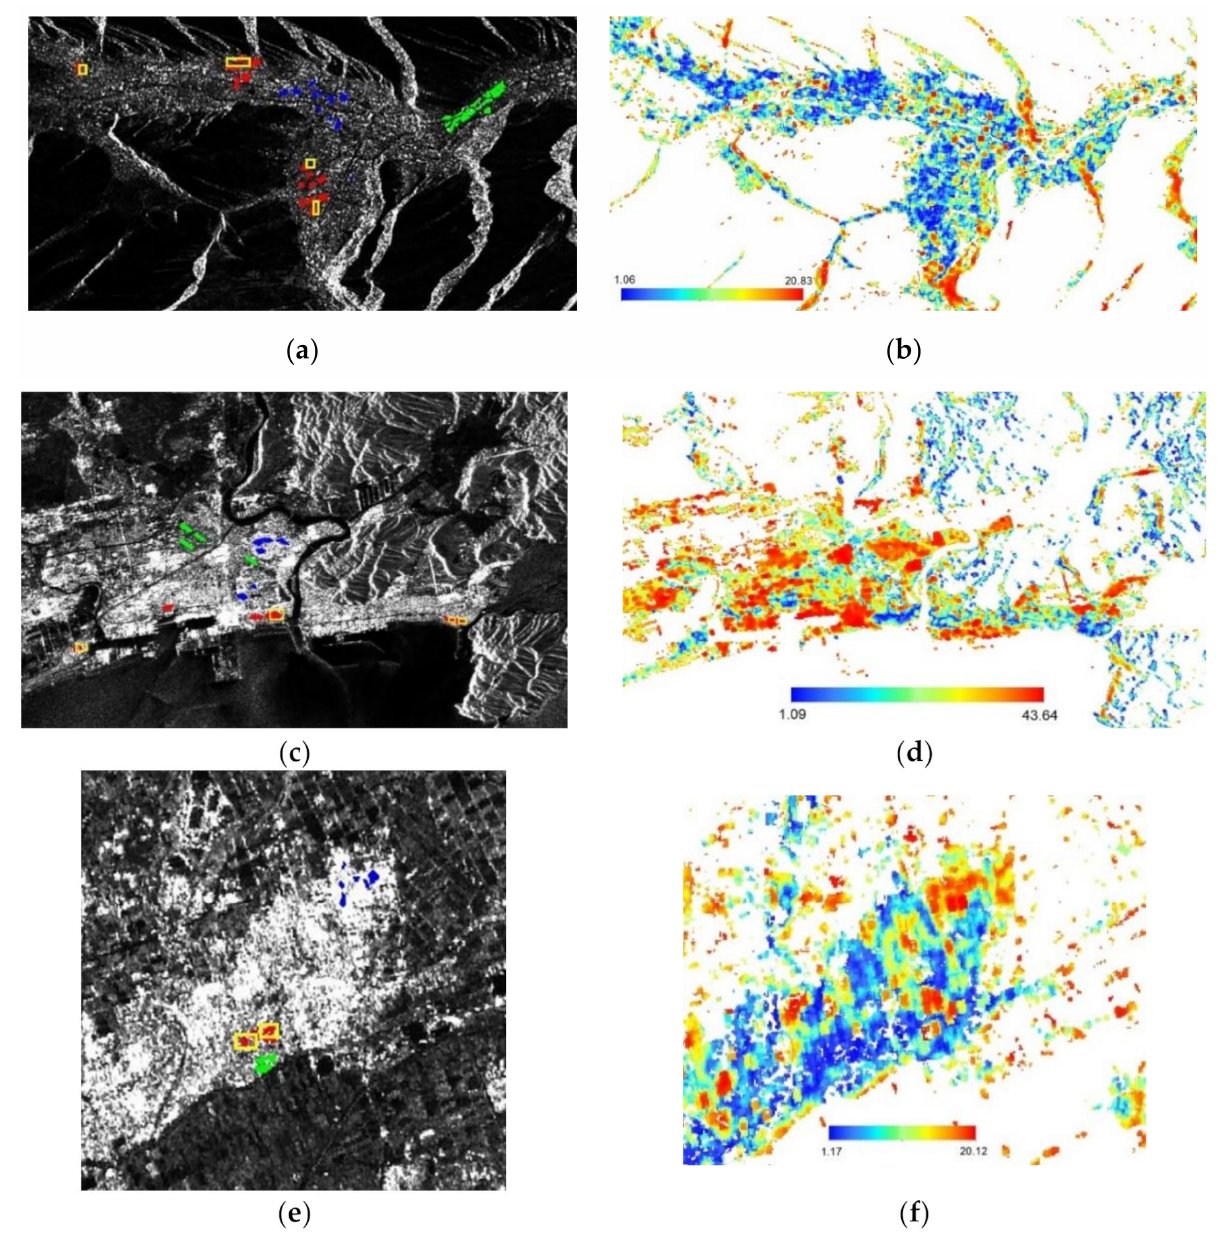
Figure 20. The results of the MaxC feature and the samples in three study sites: ( a ) the samples in the Yushu study site; ( b ) the result of the MaxC feature in the Yushu study site; ( c ) the samples in the Ishinomaki study site; ( d ) the result of the MaxC feature in the Ishinomaki study site; ( e ) the samples in the Mashiki town study site; ( f ) the result of the MaxC feature in the Mashiki town study site. In subfigures ( a ), ( c ), and ( e ), yellow rectangles show the target sample sets used for the OPCE matching algorithm; red patches show the collapsed building samples used to draw the pdfs of collapsed buildings in Figures 15–17 and Figures 21–23; green patches show the obliquely-oriented building samples used for drawing pdfs of obliquely-oriented buildings in Figures 15–17 and Figures 21–23; and blue patches show the orthogonally-oriented building samples used for drawing pdfs of orthogonally-oriented buildings in Figures 15–17 and Figures